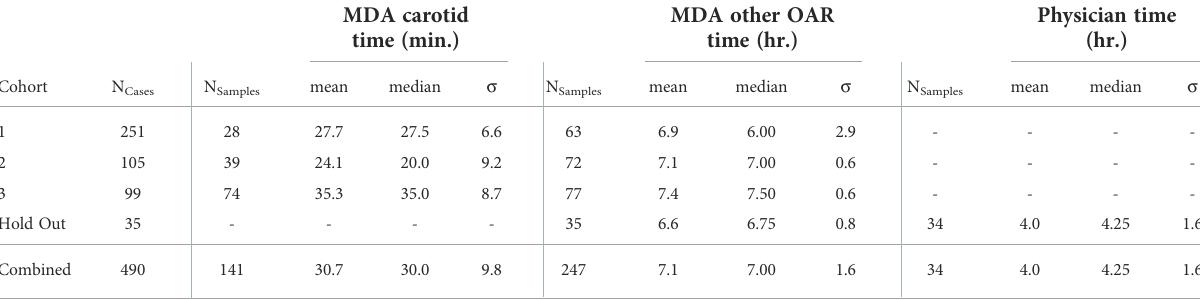
TABLE 4 Mean, median and standard deviation of time spent per recorded case by H&N anatomy experts for OAR segmentation and related revisions, broken down per cohort subset. MDA carotid time (min.) time